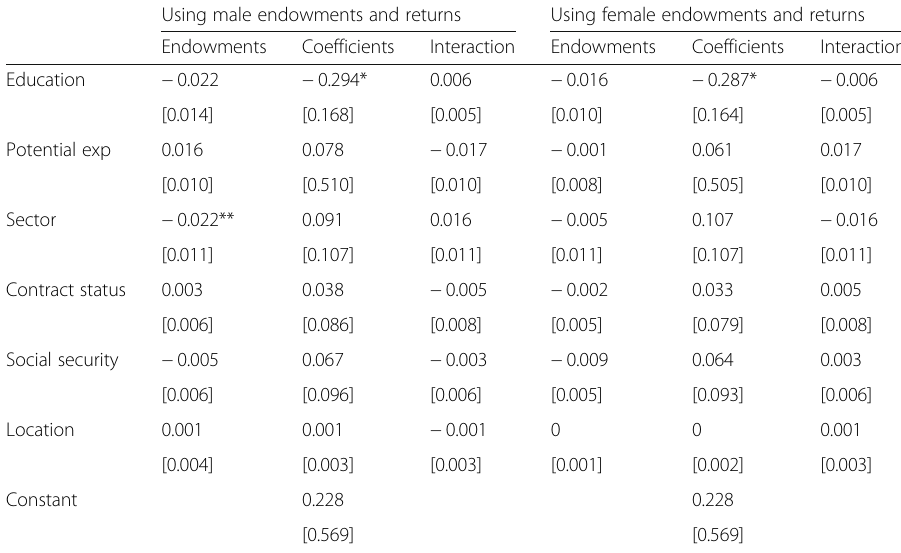
Table 15 Detailed threefold income decompositions: Macedonia Using male endowments and returns Using female endowments and returns Endowments